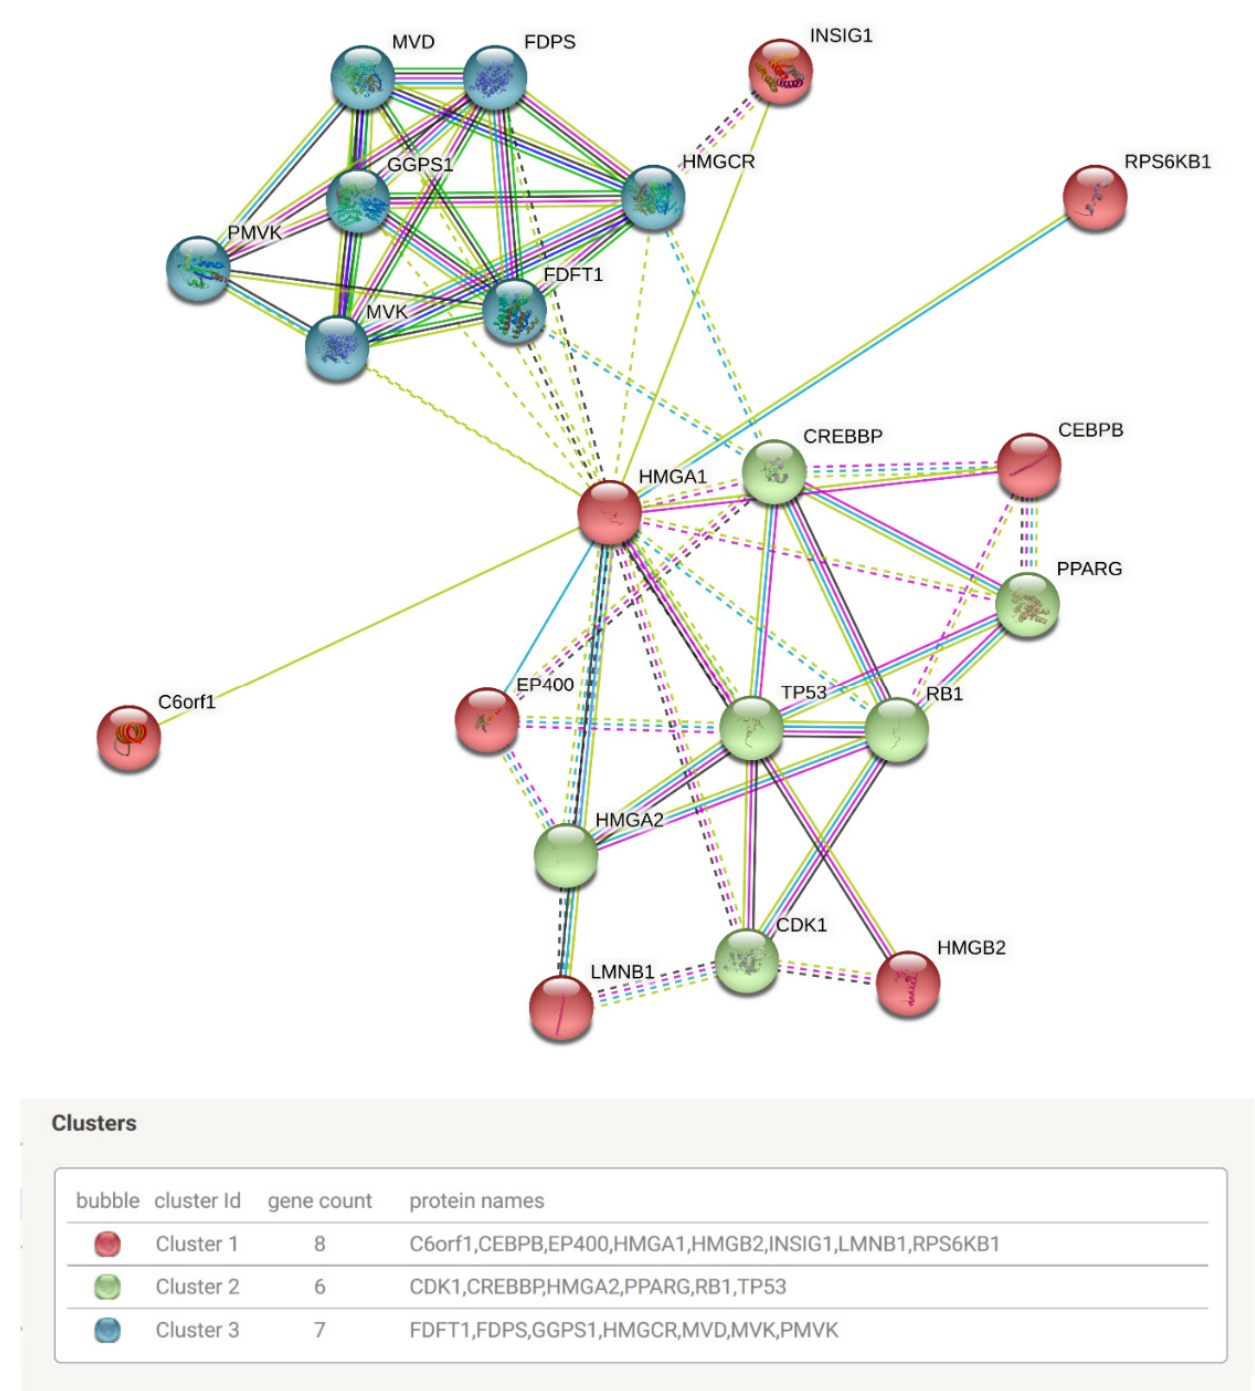
Figure 16. Clustered protein-protein interaction network of the HMGA1. Edges of clusters were indicated by dotted lines.